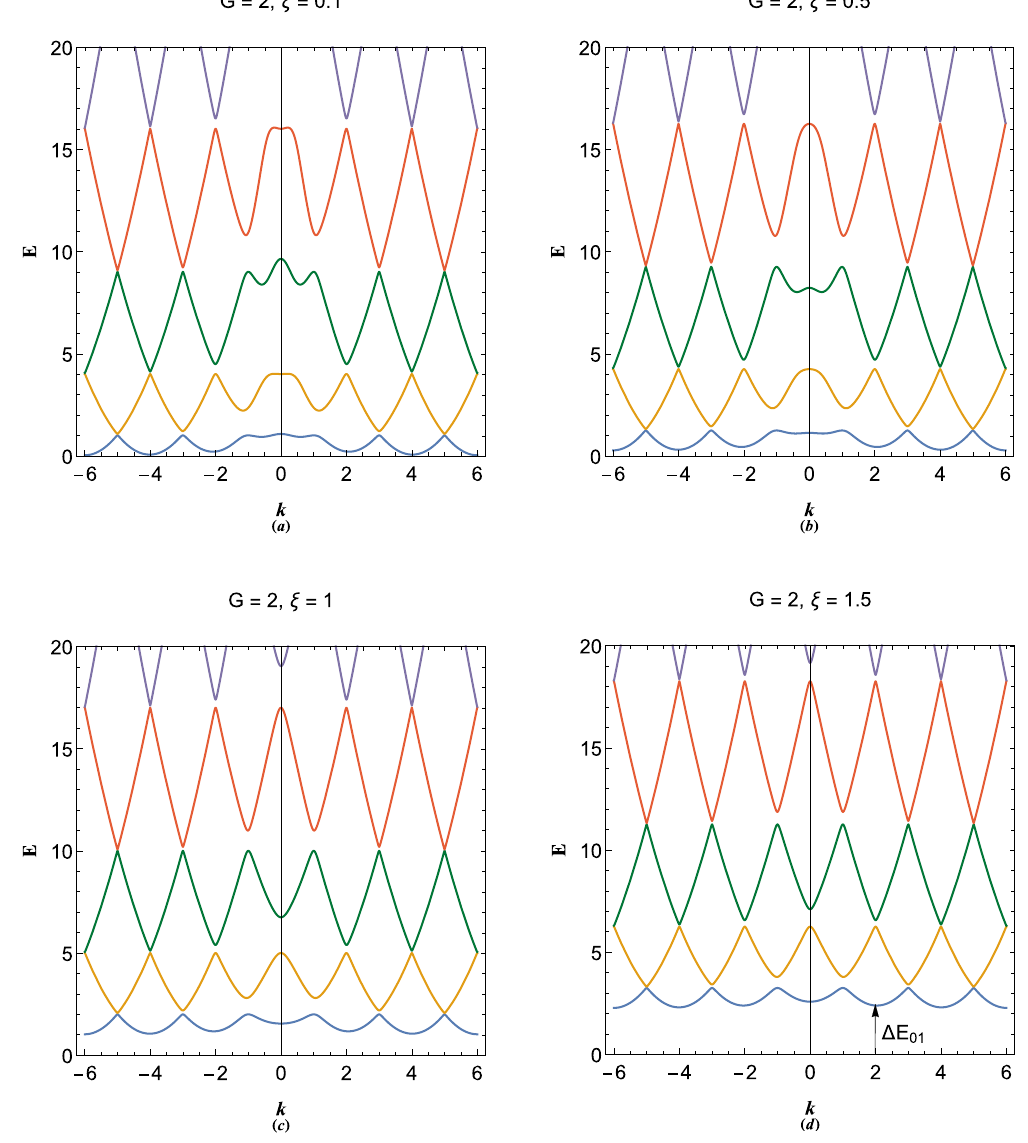
Figure 9. Variation in the electronic band structure of plasmon excitations in a plasmonic crystal with 2 π/ a for ( a ) ξ G =